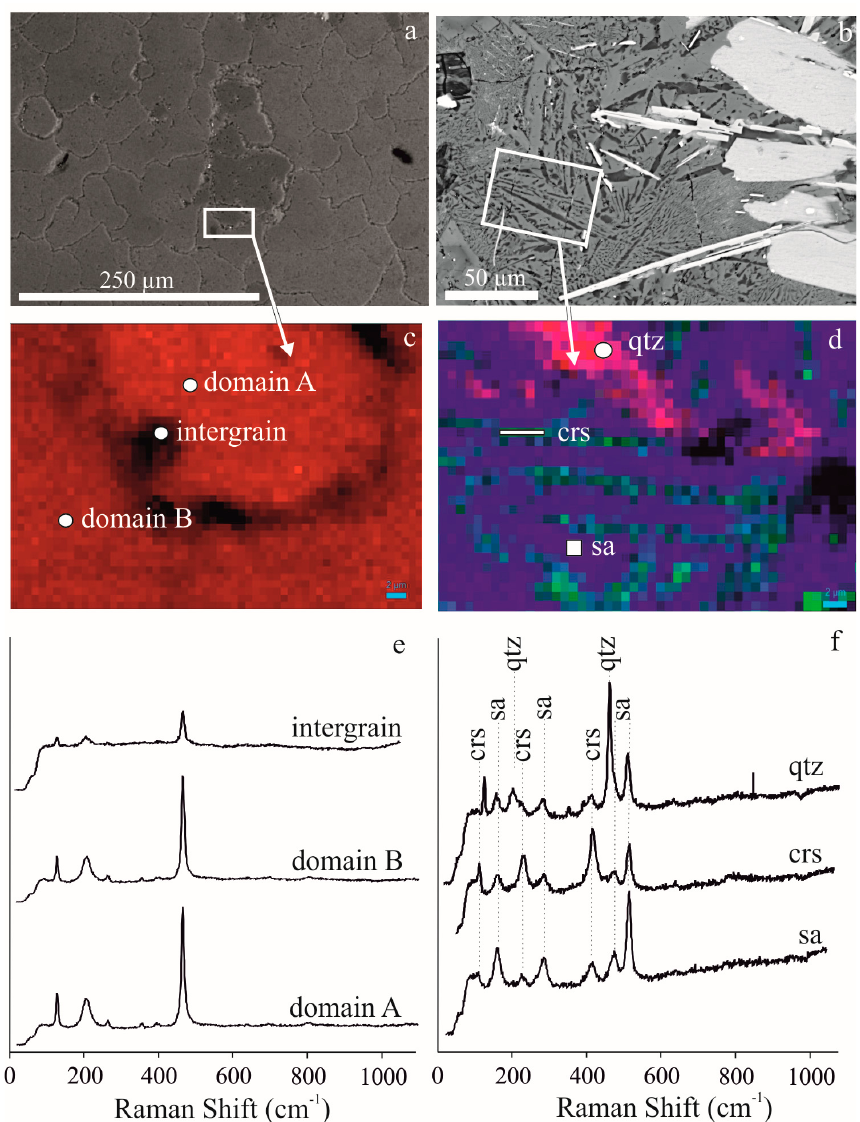
Figure 6. ( a ) BSE image of ballen bulk; ( b ) BSE image of ballen rim; white boxes show Raman spectrum measurement area; ( c , d ) maps of phase distribution based on Raman band intensities (red, quartz Raman band 464 cm –1 ; blue, sanidine band 514 cm –1 ; green, cristobalite band 415 cm –1 ), white circle, rectangle, and square show Raman spectrum measurement area; ( e , f ) Raman spectra; qtz, quartz; sa, sanidine; crs, cristobalite.